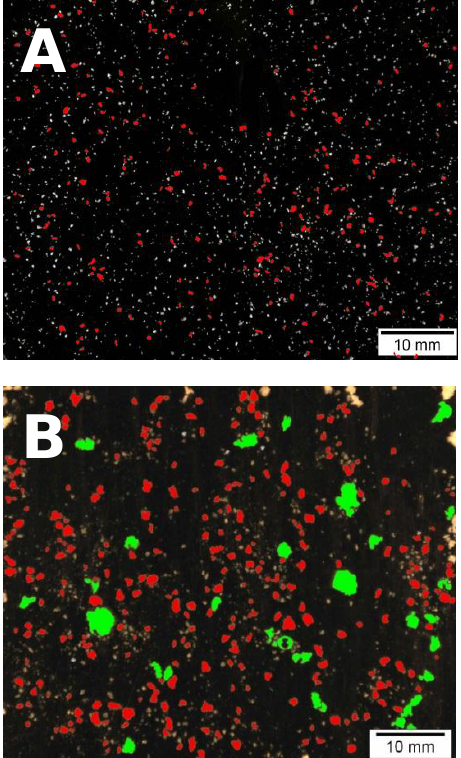
Figure 1. Image analysis of wheat straight dough bread (Bread 1) ( A ) and refined rye bread (Bread 6) ( B ) after chewing in mouth and in vitro incubation with pepsin: diameter of particles ≥ 2 mm shown green, diameter of particles < 2 mm shown red, diameter of particles < 1 mm shown grey.